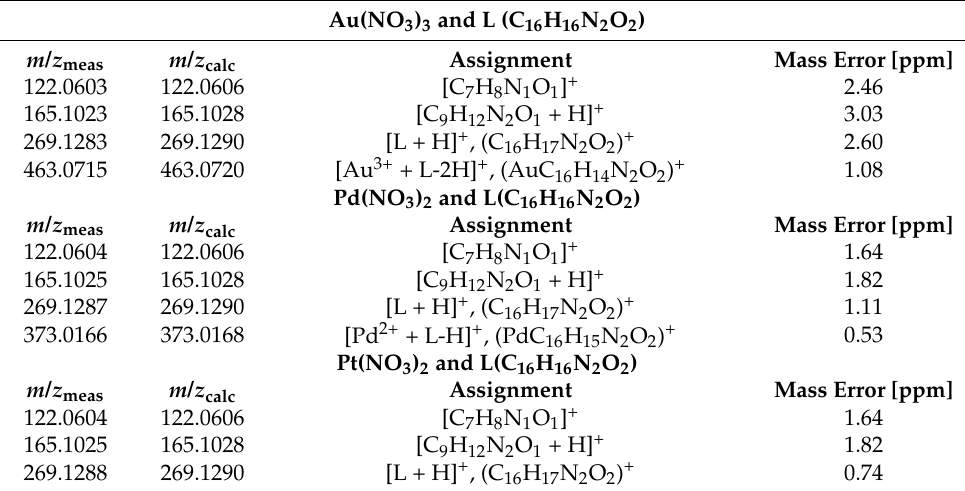
Table 5. ESI HRMS data of the main ions found in the samples of the separated organic phases after liquid–liquid extraction (performed for samples in which the molar ratio of metal ions to ligand (M:L) was 1:5, L- N,N' -bis(salicylidene)ethylenediamine) diluted (1:1) in